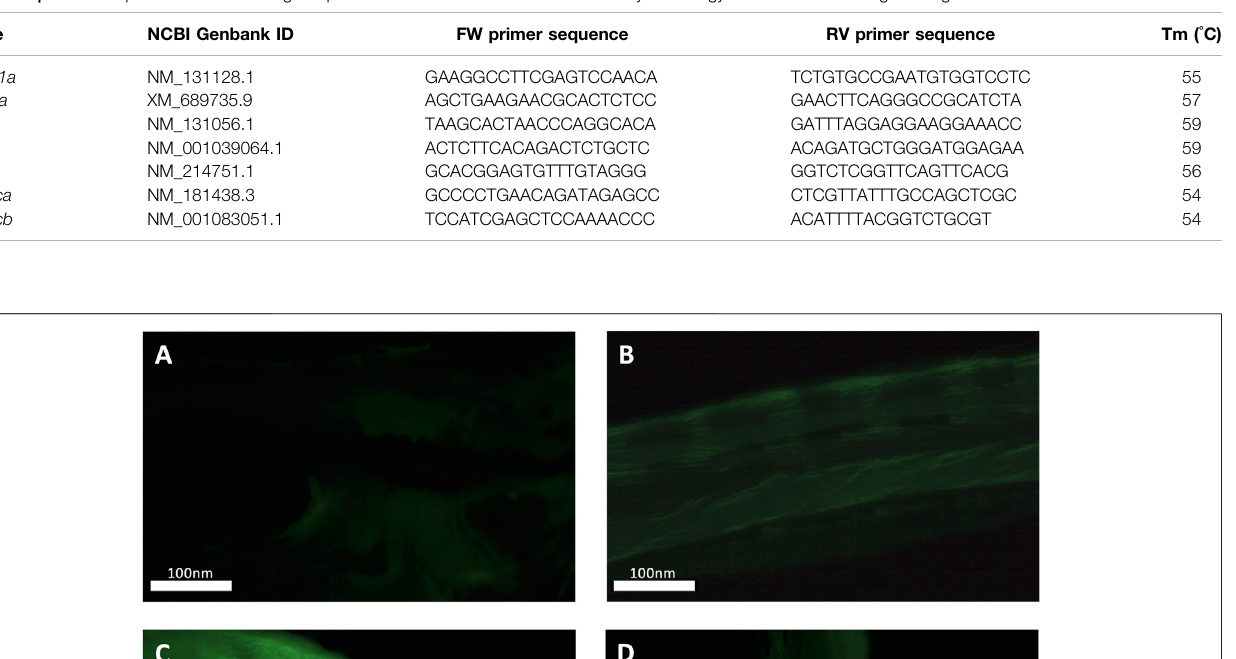
TABLE 1 | Primer sequences and annealing temperatures used in real-time RT-PCR assay for energy metabolism related gene targets.